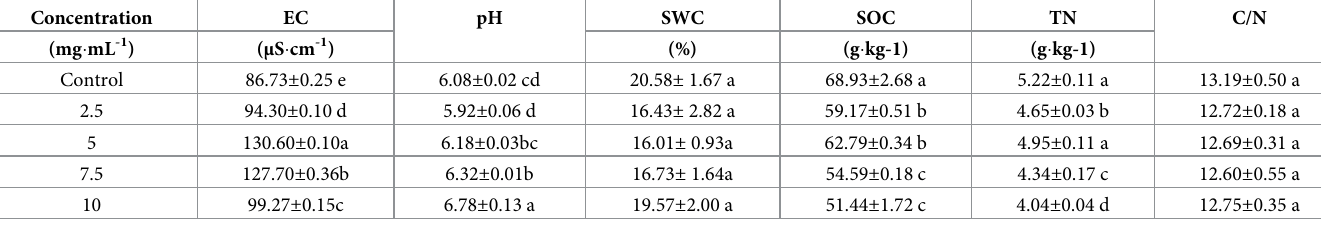
Table 2. Soil physicochemical responses to different concentrations of R . typhina root extract.